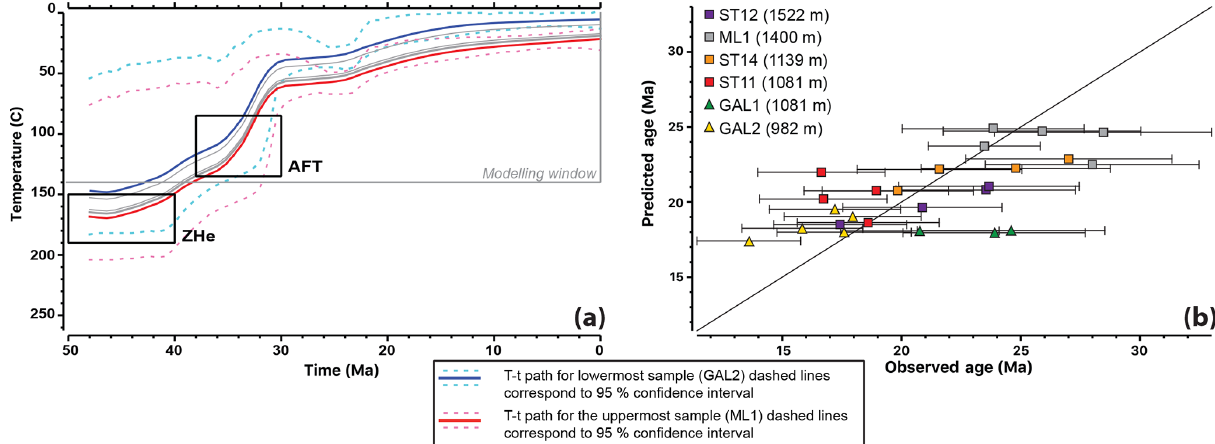
Figure 16. (a) Thermal history of the Têt fault hanging wall. Thermal modelling was computed with QTQt software (Gallagher, 2012) and Gautheron et al. (2009) diffusion parameters using AHe data from the HW except samples close to the Têt fault. AFT and ZHe data are from Maurel et al. (2008). (b) Predicted age vs. observed age graph for each apatite grain. The 1 : 1 diagonal line is for an ideal fit of these